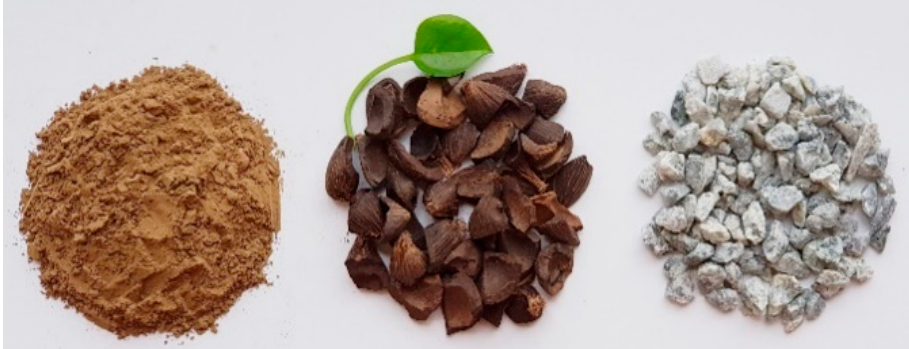
Figure 4. FA, OPS lightweight aggregate and crushed granite used for concrete mixtures.